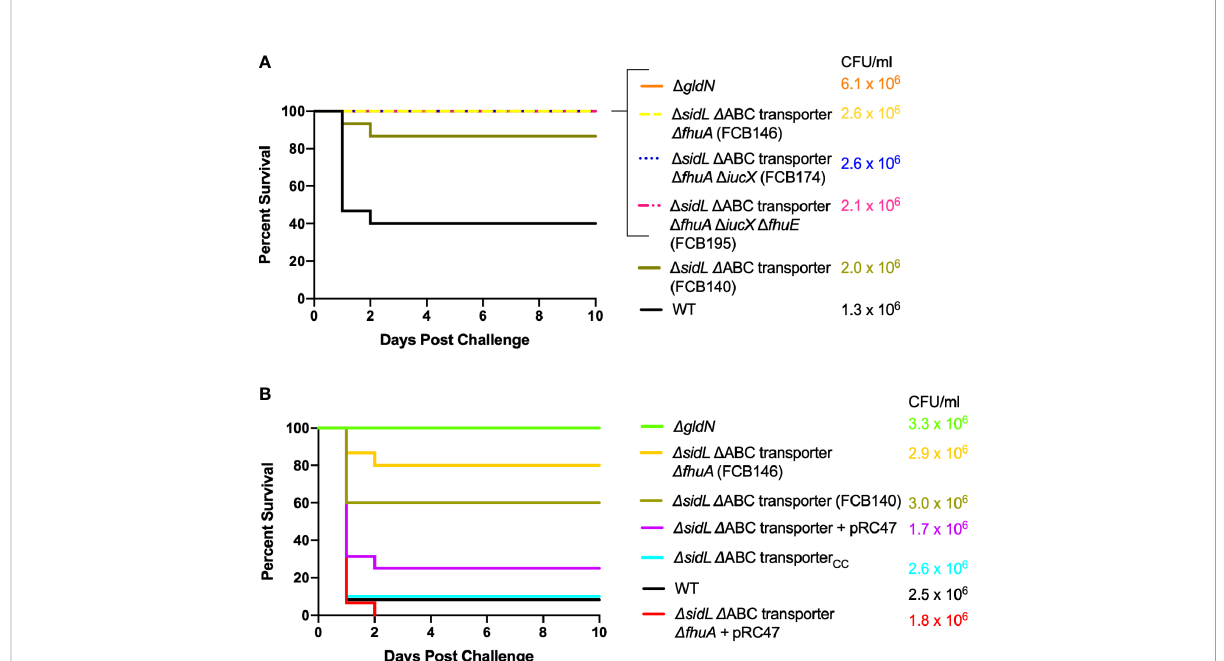
FIGURE 7 Virulence of F. columnare wild type and mutants predicted to be defective for multiple steps of iron uptake. Adult zebra fi sh were exposed by immersion to F. columnare strains and percent survival was recorded. (A) Wild type (black), D gldN (orange), D sidL D ABC transporter (FCB140) (olive), D sidL D ABC transporter D fhuA (FCB146) (yellow), D sidL D ABC transporter D fhuA D iucX (FCB174) (blue), and D sidL D ABC transporter D fhuA D iucX D fhuE (FCB195) (pink). The fi nal challenge concentrations for each strain are shown in the corresponding color. Signi fi cant differences in the percent survival for fi sh challenged with F. columnare were seen between WT and FCB140 (P < 0.01), WT and FCB146 (P < 0.001), WT and FCB174 (P < 0.001), and WT and FCB195 (P < 0.001). (B) Wild type (black), D gldN (green), FCB140 (olive), FCB140 complemented with pRC47 (purple), FCB140 complemented by inserting the ABC transporter genes back into the chromosome (blue), FCB146 (yellow), and FCB146 complemented with pRC47 (red). pRC47 carries genes encoding the ABC transporter proteins. Signi fi cant differences in the percent survival for fi sh challenged with F. columnare were seen between WT and FCB140 (P < 0.01), WT and FCB146 (P < 0.0001), FCB140 and FCB140 complemented with pRC47 (P < 0.05), FCB140 and FCB140 chromosomally complemented with the ABC transporter genes (P < 0.01), and FCB146 and FCB146 complemented with pRC47 (P <